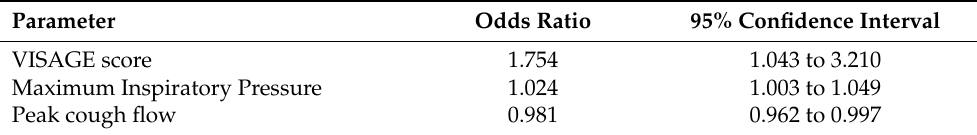
Table 4. Estimates of the evaluated parameters by odds ratio.